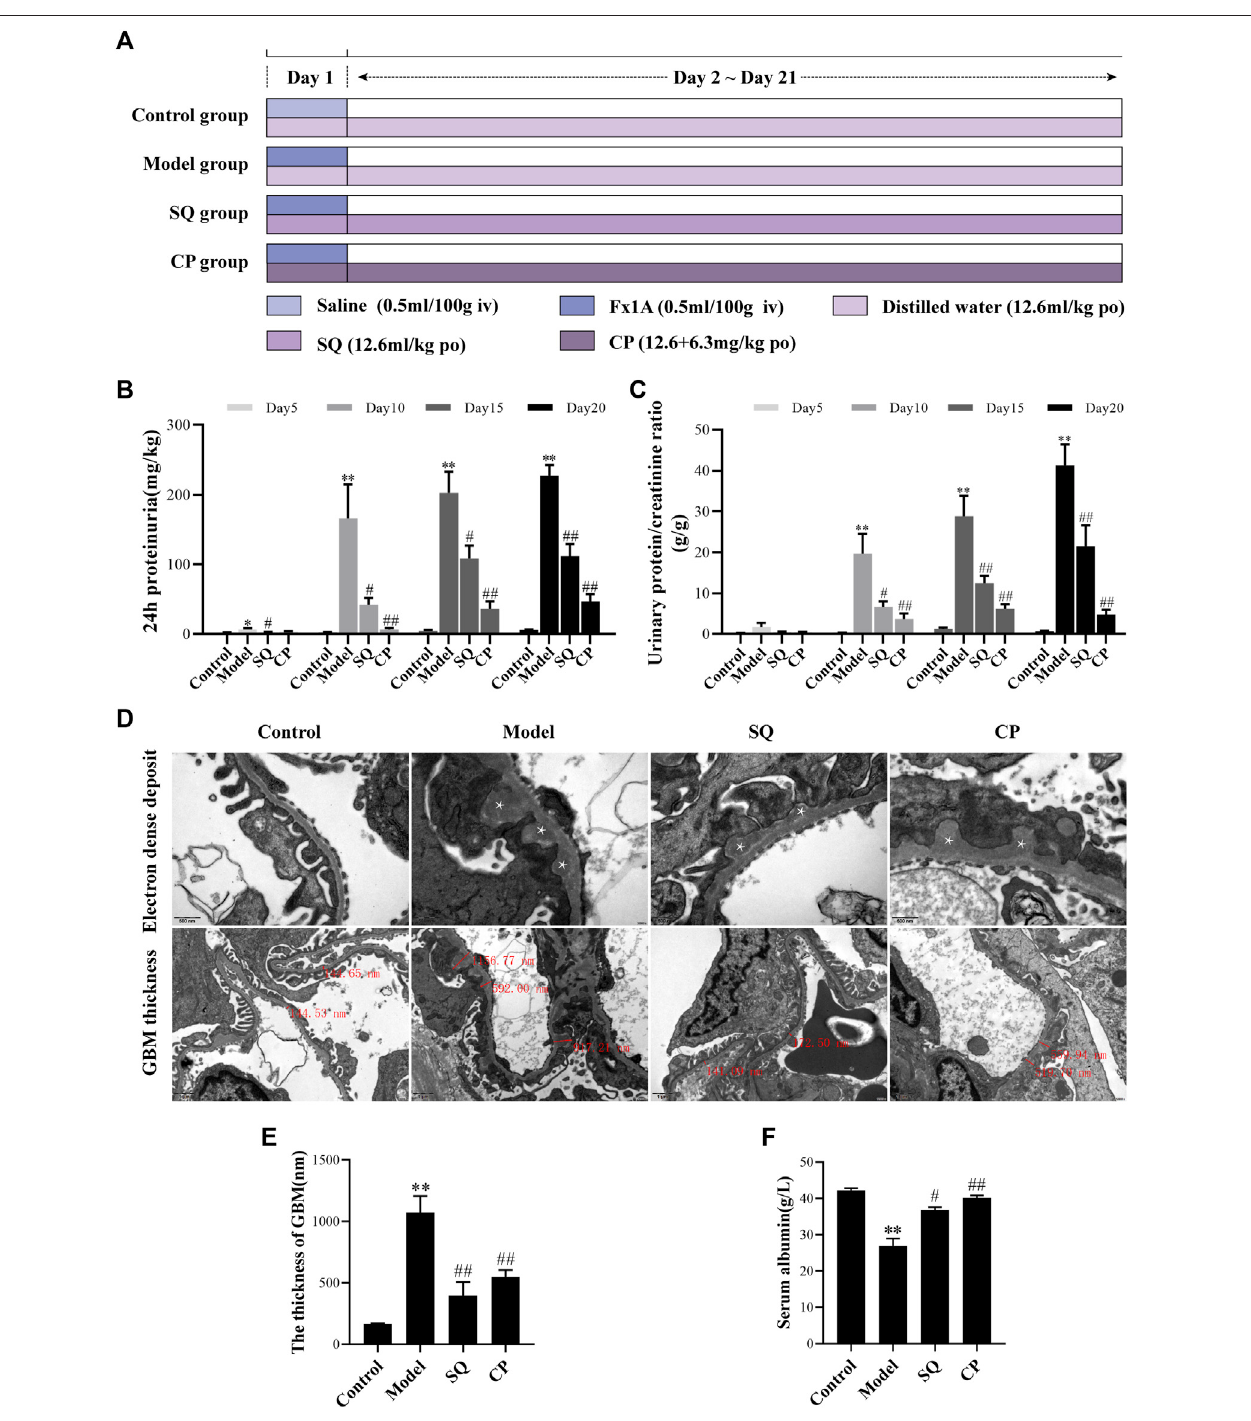
FIGURE 1 | SQ diminished proteinuria and pathomorphologic injury in PHN rats. The experiment was implemented referring to the animal experimental progress schedule (A) . After SQ and CP intervention, the 24-h proteinuria (B) and the urinary protein/creatinine ratio (C) levels of PHN rats were signi fi cantly reduced and serum albumin (F) levels were markedly restored ( n (cid:1) 6). TEM examination of ultrathin kidney sections (D) showed changes of subepithelial glomerular immune deposits (magni fi cation × 30,000, asterisks) and thickening of the GBM (magni fi cation × 12,000) of rats in each group. Semi-quanti fi cation of GBM thickness (E) was analyzed ( n (cid:1) 6). Data are represented as mean ± SD from independent groups. * p < 0.05 vs. Control group. ** p < 0.01 vs. Control group. # p < 0.01 vs. Model group. ## p < 0.01 vs. Model group.